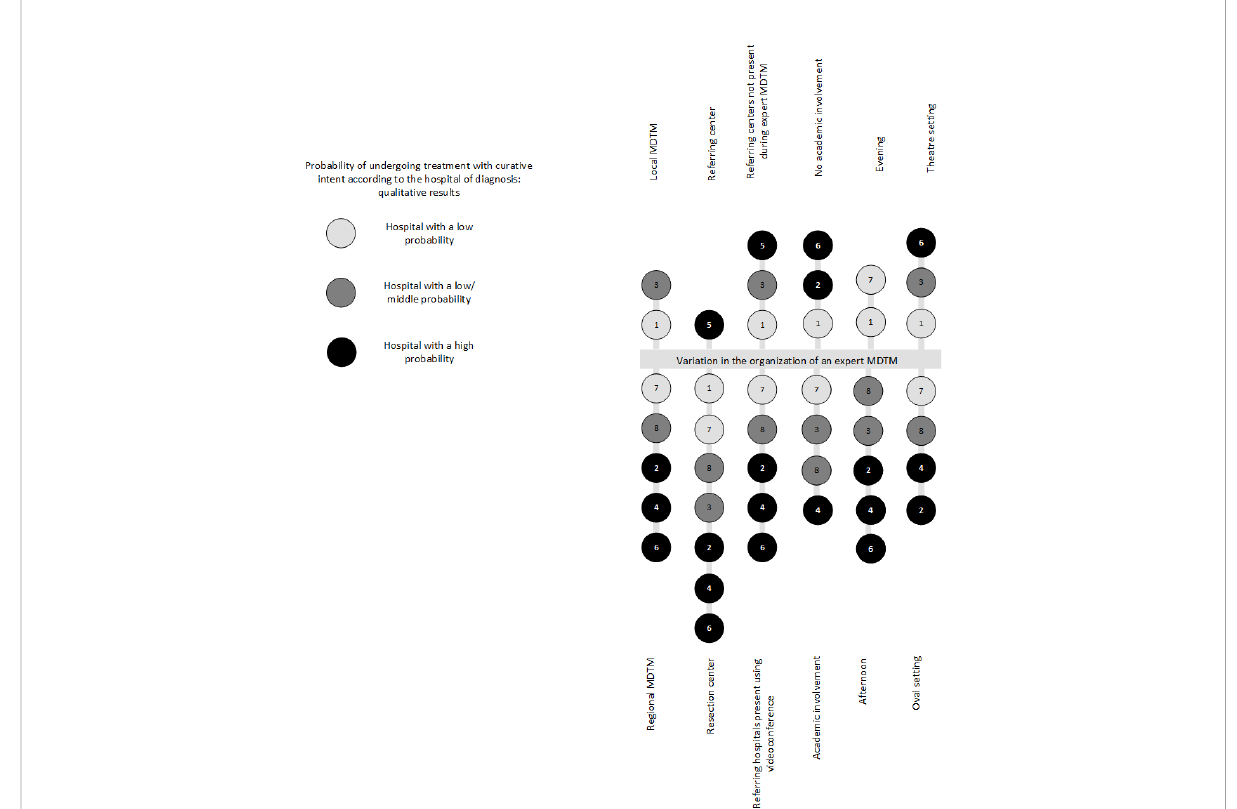
FIGURE 1 Variability in the organization of an expert MDTM. All participating hospitals are displayed in this fi gure. Each included hospital is represented in the form of a circle, including a hospital number. In addition, the probability groups are represented by different shades of gray. The referring hospital is only partly represented in this fi gure. MDTM, multidisciplinary team